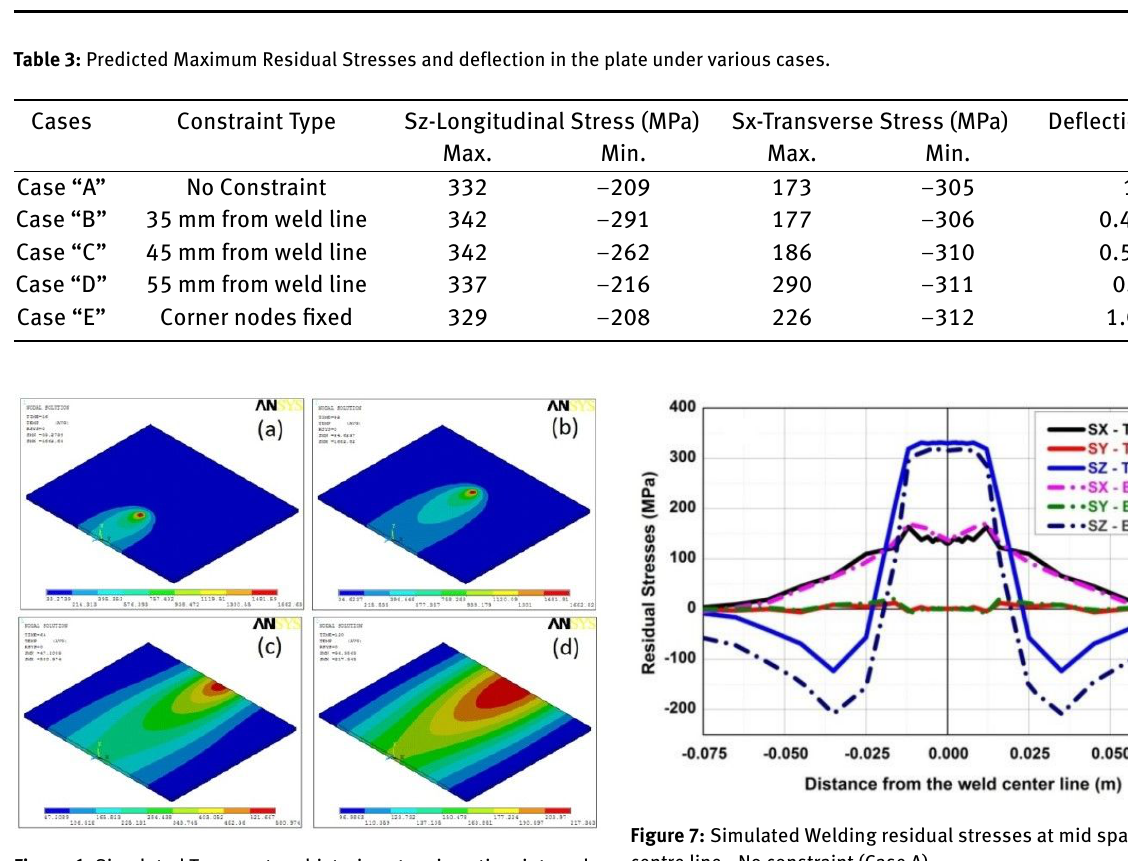
Figure 6: Simulated Temperature histories at various time intervals: (a) 16 sec (b) 32 sec (c) 64 sec and (d) 120 sec.